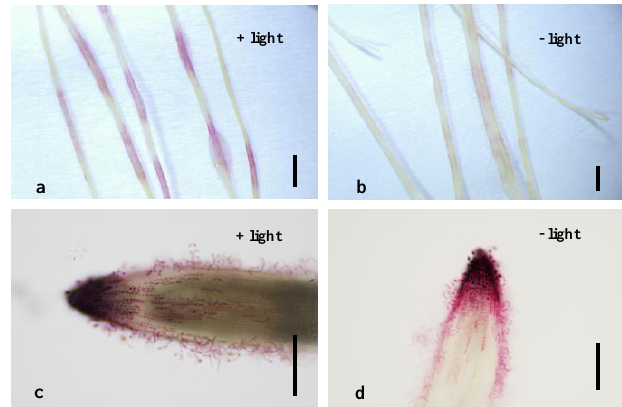
Figure 2. Light induces endogenous anthocyanin production in A17 roots but does not affect pMtRC-MtLAP1 visual screening of transgenic roots. ( a ) A17 roots showed purple sections in roots after transformation with pMtRC-MtLAP1 when grown under normal light conditions; ( b ) A17 roots showed few purple sections after transformation with pMtRC- MtLAP1 when grown under normal light conditions with roots shielded from light; ( c ) Anthocyanin pigments accumulate in root tips of A17 composite plants transformed with pMtRC-MtLAP1 with growth under normal light conditions; ( d ) Anthocyanin pigments in the A17 root tip after transformation with pMtRC-MtLAP1 with roots shielded from light. Plants were grown in an incubator on plates containing MFP medium. Bars are 1 mm ( a , b ), 150 µm ( c ), and 200 µm ( d